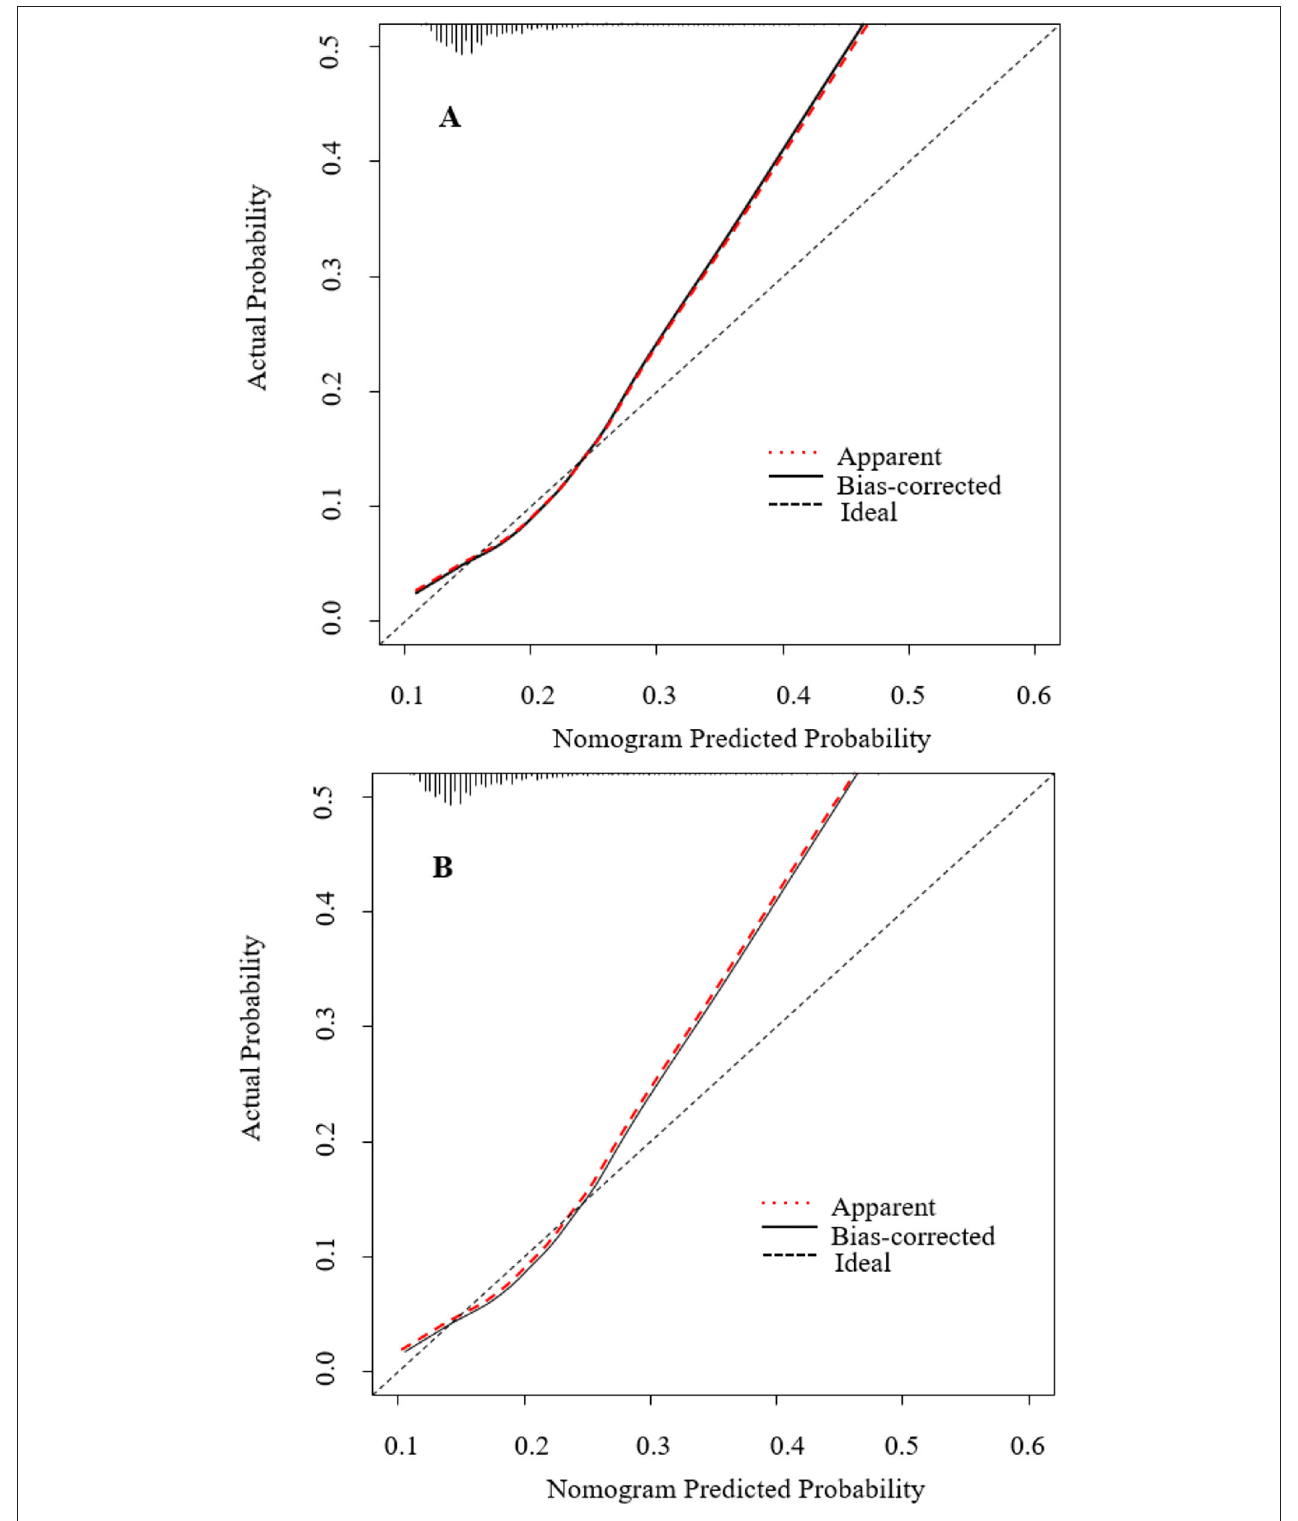
FIGURE 5 | Calibration plot for nomogram in the (A) development dataset and (B) validation dataset. The 45 ◦ dashed line represents ideal predictions. The plot illustrates the accuracy of the multivariable model (“Apparent”) and the bootstrap model (“Bias-corrected”) for predicting willingness of family doctor. Locally